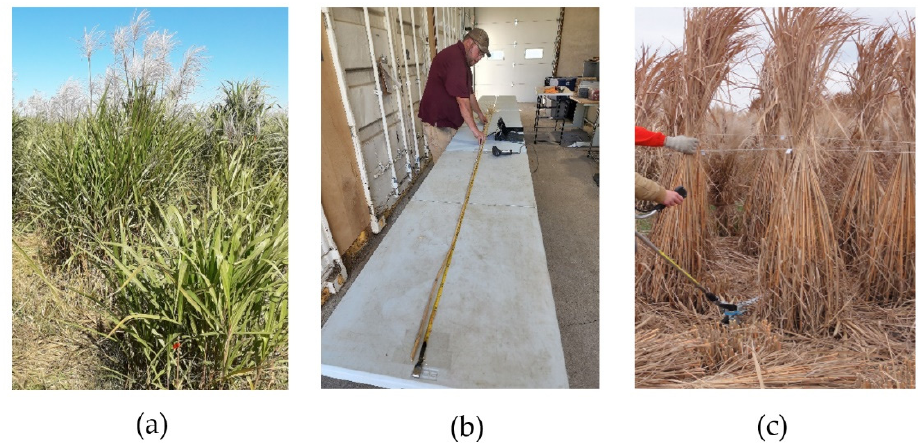
Figure 2. Example cases of plant traits collected during field activities and used as ground-truthing for model implementation and validation. Examples of ( a ) early (back) and late (front) flowering time, ( b ) culm length measurement, and ( c ) biomass yield collected in seasons 2020–2021.